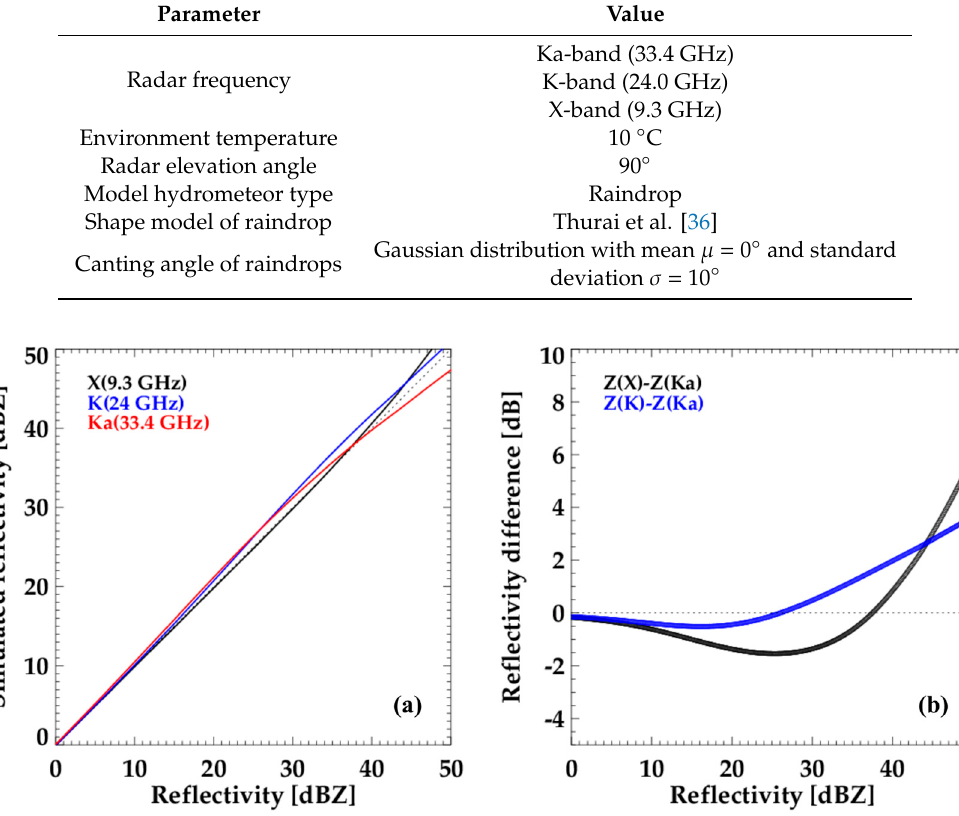
Figure 4. ( a ) Simulated reflectivities and ( b ) their differences in the three wavelengths, Ka (cloud radar), K (MRR), and X-band (VertiX) by assuming the Marshall–Palmer DSDs [35]. The x-axis is the reflectivity values from Equation (1), and the y-axis is derived from the scattering simulation with the condition shown in Table 3.